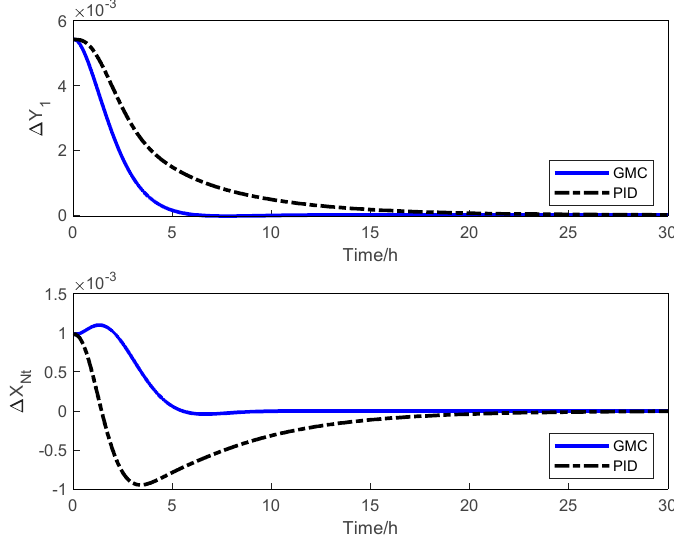
Figure 12. Servo response curve at top and bottom of tower.